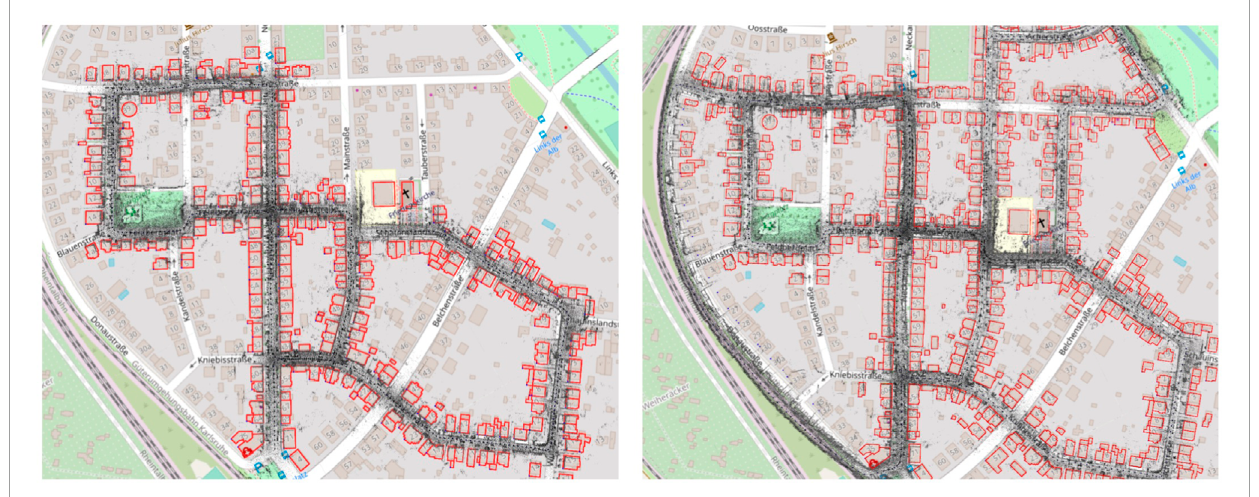
FIGURE 9 Evolution of the trajectory and 3D map estimation on Sequence 00, using Prior SLAM.